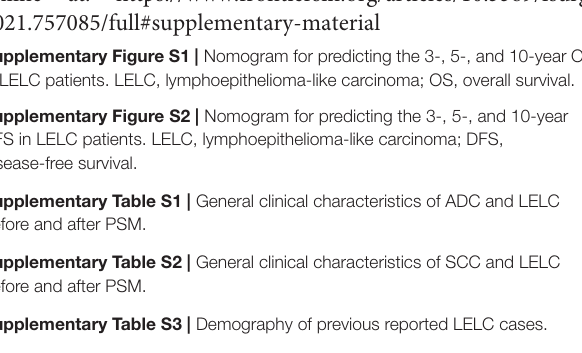
Supplementary Table S1 | General clinical characteristics of ADC and LELC before and after PSM. Supplementary Table S2 | General clinical characteristics of SCC and LELC before and after PSM. Supplementary Table S3 | Demography of previous reported LELC